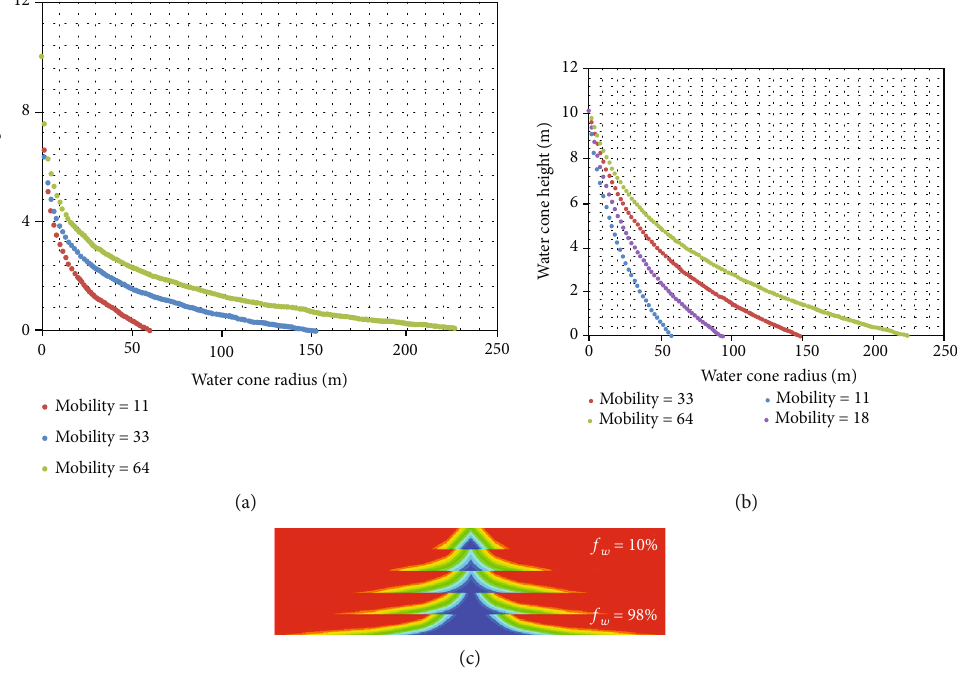
Figure 3: The in fl uence of di ff erent water-cut stages on water cone behavior through mathematical calculation and physical simulation.